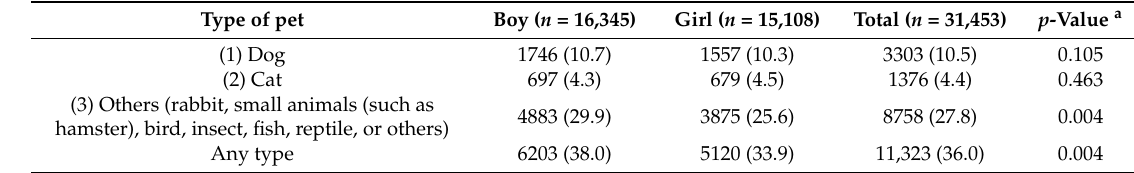
Table 1. Prevalence (%) of pet ownership and its components (N = 31,453).